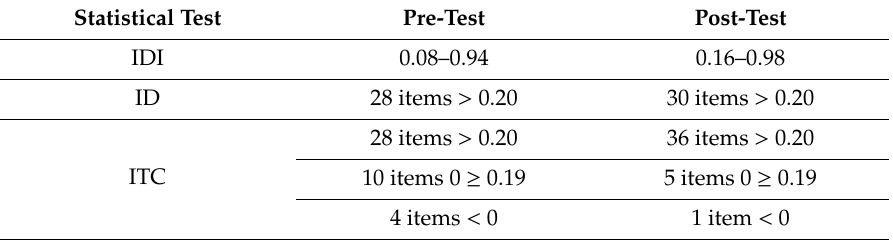
Table 3. Summary of instrument assessment as pre and post-test.